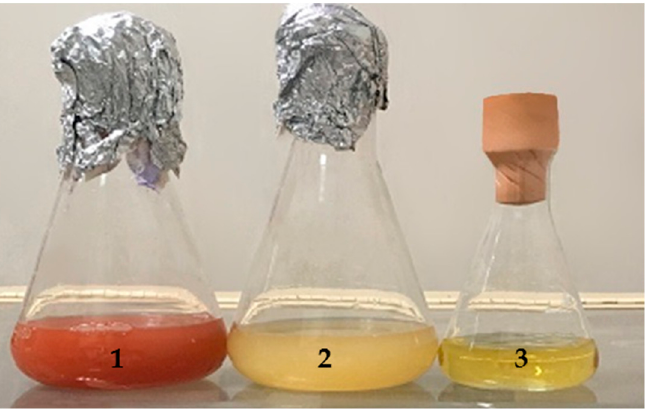
Figure 7. Selenite reduction by the haloalkaliphilic 5AG strain grown in medium A at 36 °C for 24 h and 200 rpm. Flask 1: The 5AG strain grown in the presence of 200 ppm Na 2 SeO 3 . Flask 2: The 5AG strain grown in the absence of Na 2 SeO 3 . Flask 3: Total of 200 ppm Na 2 SeO 3 incubated in medium A. The biogenic synthesis of SeNPs by the 5AG strain was probably an intracellular process, as already described for other biogenic systems [10,26]. Nevertheless, it cannot be excluded that the biosynthesis could also have taken place on the cells’ surface. After centrifugation of the incubation mixture, as shown in Figure 8a, the red color was retained by the cells, whereas the cell-free supernatant did not show any red coloration. A similar result was obtained by growing the 5AG strain in the solid medium A; as shown in Figure 8b, the red color was found only in association with the cells, which could be compatible either with intracellular synthesis or with NP production closely associated to the cells’ membrane. Figure 8. The 5AG strain’s cellular localization of selenite reduction products in medium A. Panel ( a ) cells incubated in liquid medium; Panel ( b ) cells incubated in solid medium. For the optimization of the synthesis protocol, the effect of the chemical composition of the growth medium was also tested. Therefore, further experiments were carried out